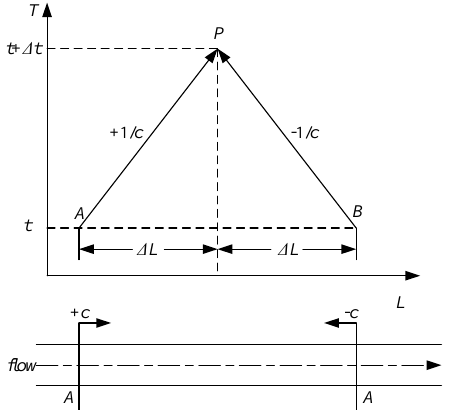
Figure 3. Schematic diagram of the characteristic line method.